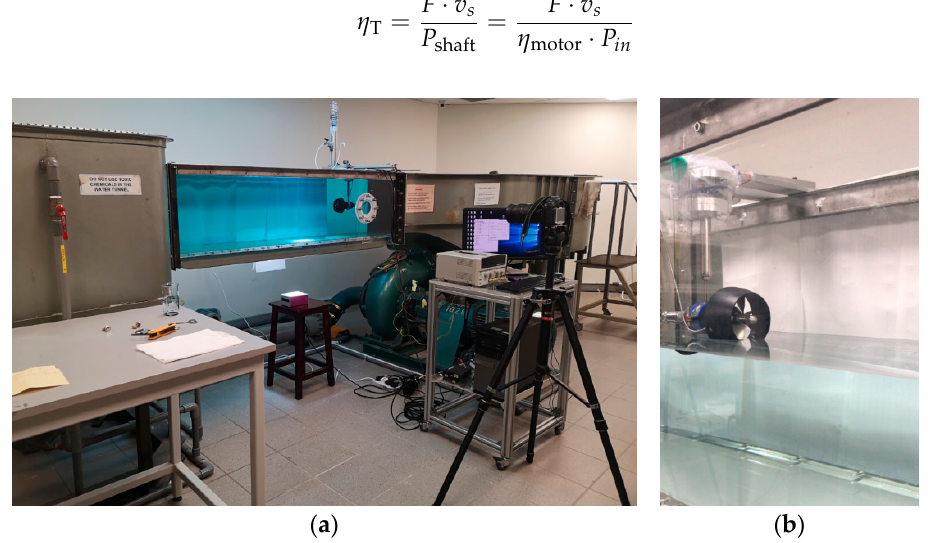
Figure 2. Test rig and the ducted propeller installation. ( a ) Test rig; ( b ) Ducted propeller installation.